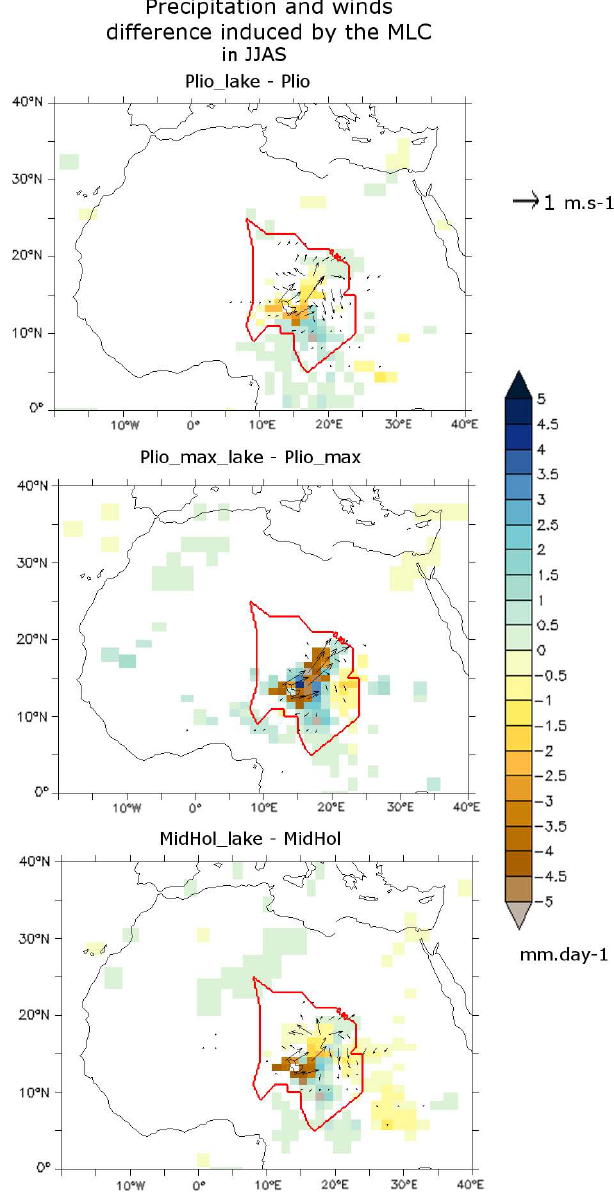
Fig. 6. JJAS precipitation and 10m winds difference between “lake” experiments and standard experiment for each climatic configura- tion. Difference is significant at 95% in a Student’s t test.